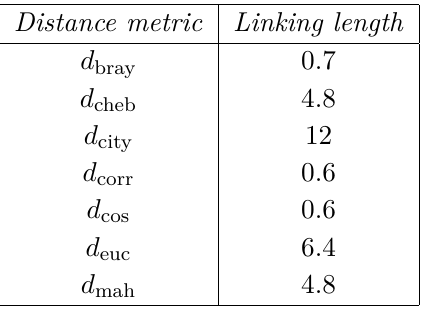
Table 1. Linking length values used for each distance metric for our prototype electroweakino